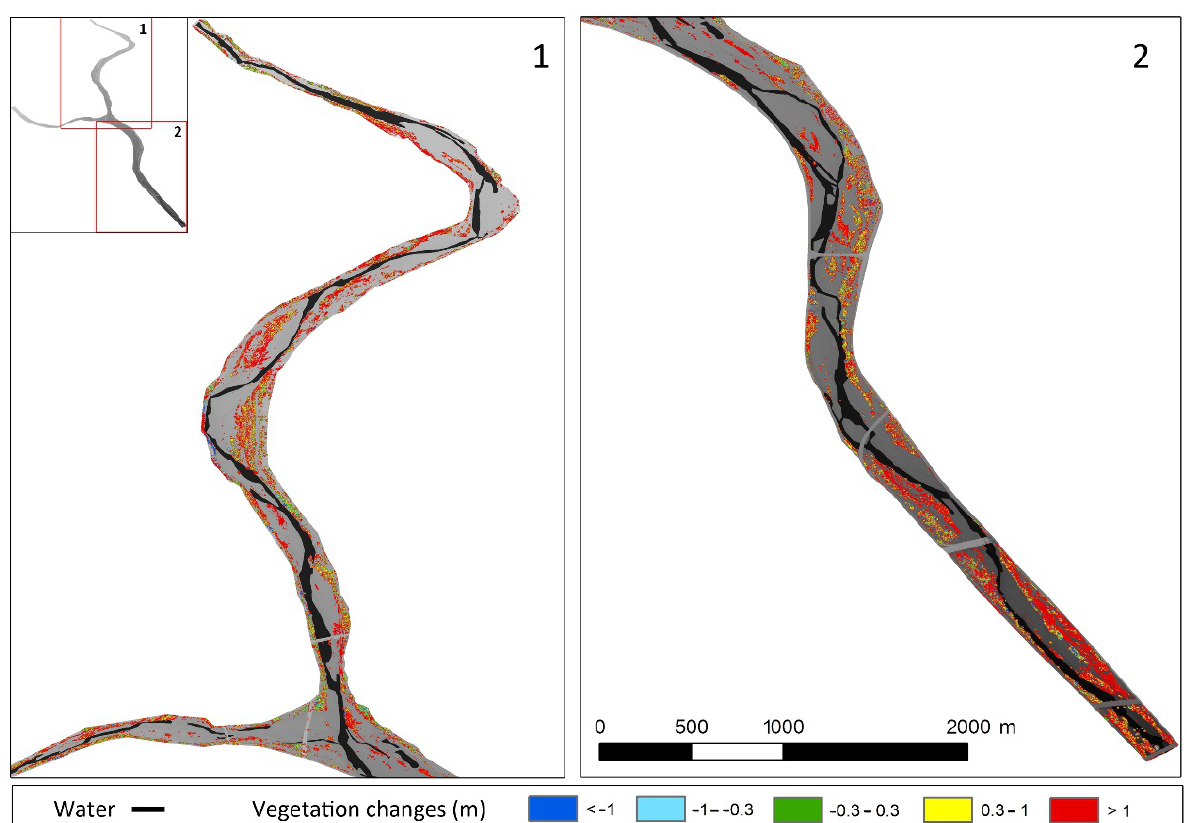
Figure 12. Vegetation height changes between 2017 and 2018 surveys.